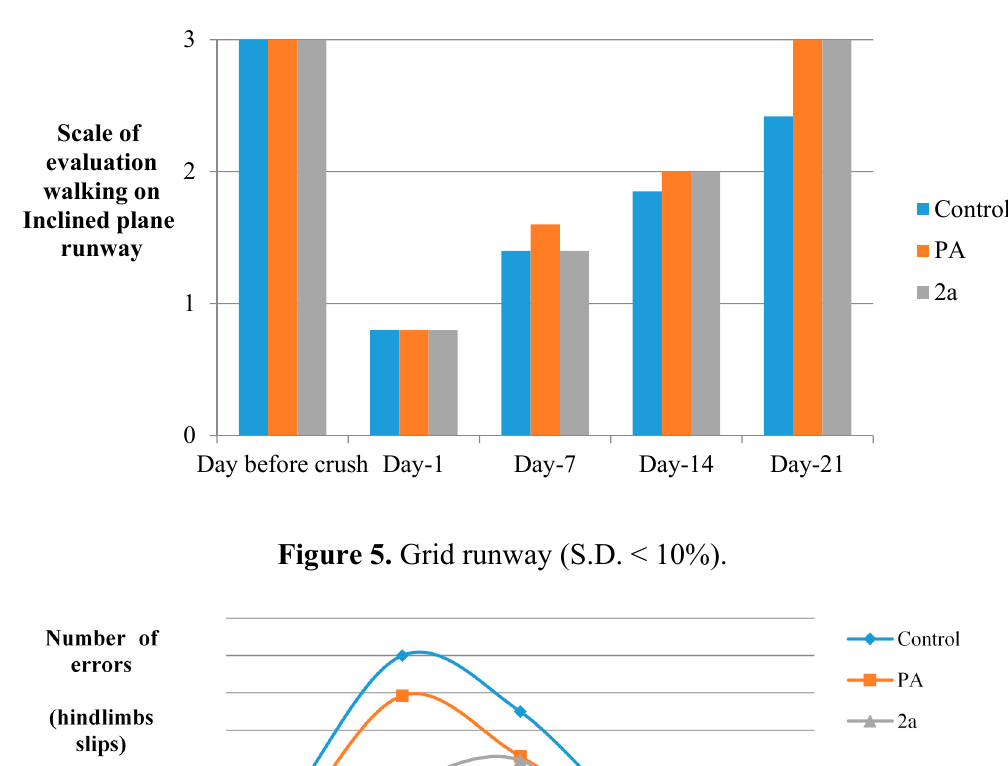
Figure 4. Inclined plane runway (S.D. < 10%).